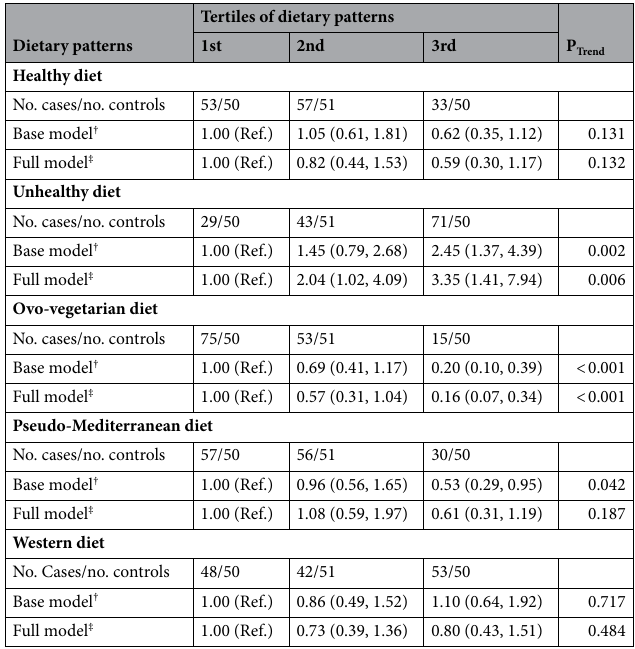
Table 4. Association between tertiles of dietary patterns and odds of bacterial vaginosis among the participant. Logistic regression model. † Base OR. ‡ Adjusted for familial history of BV, BMI (Kg/m 2 ), WC (cm), cigarette smoking, energy intake (Kcal/day), calcium supplement use and physical activity